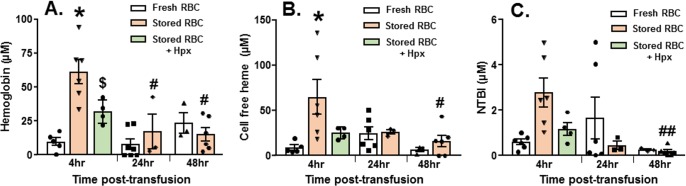
Changes in plasma hemoglobin, heme, and non-transferrin-bound iron (NTBI) after trauma hemorrhage (TH) and resuscitation with stored blood.At various times after TH and resuscitation with fresh (day 0) or stored (day 14) red blood cells (RBCs), mouse plasma was collected and free hemoglobin (A), heme (B), and NTBI (C) measured. Each symbol represents an individual sample. Data are mean ± SEM; *p < 0.001 relative to fresh RBCs at 4 h. #p < 0.001 and ##p = 0.02 relative to stored RBCs at 4 h by 2-way ANOVA with Tukey post-test. $p = 0.034 by unpaired t test relative to stored RBCs at 4 h.